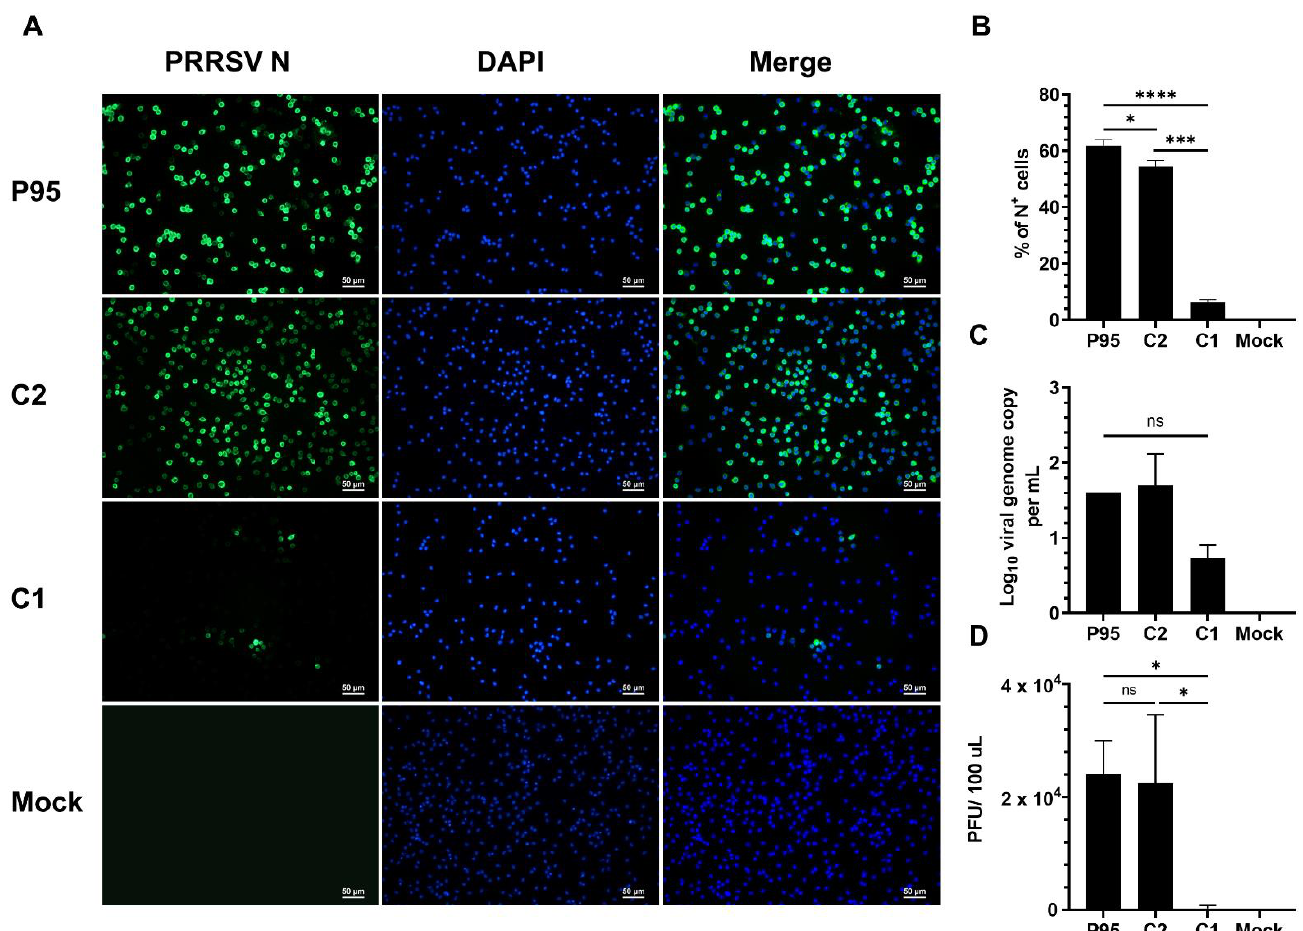
Figure 2. Infectivity of NCV1 P95 and its derived clones in PAMs at high MOI. PAMs collected from four piglets were inoculated with the NCV1 P95 and its derivatives C1 and C2 at an MOI of 10. All data were collected at 12 hpi. ( A ) Representative images of cells that were fixed and stained with an anti-N antibody to visualize virus-infected cells (green color). DAPI was used to stain the nuclei (blue color) . Scale bar = 50 μm. ( B ) Percentage of PAMs expressing N protein (N + ) as quantified by flowcytometry. ( C ) Difference of viral genome copy numbers in the culture supernatants collected at 0 hpi and 12 hpi as quantified by RT-qPCR. ( D ) Difference of virus infectious titers in culture supernatants collected at 0 hpi and 12 hpi as quantified by plaque assay in MARC-145 cells. Data are presented as means and SEM of the three independent experiments each of which involved four populations of PAMs collected from four different pigs. ns: non-statistically significant, * p < 0.05, *** p < 0.001, **** p < 0.0001.